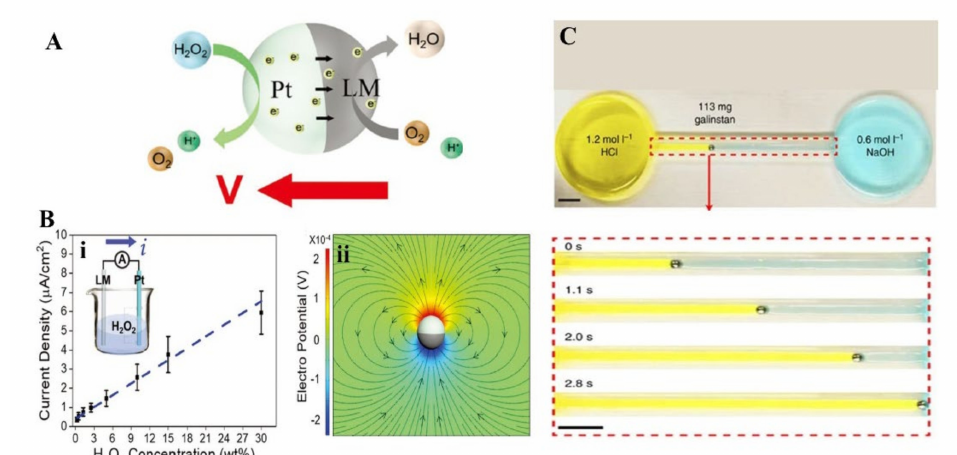
Figure 11. Chemically propelled MLMTs in H 2 O 2 or solution with PH difference. ( A ) Schematic illustration of the propulsion mechanism of Pt/Galinstan Janus motor [6]. ( B ) Electrochemical measurements ( i ) the current density of the LM–Pt system and simulated results ( ii ) of the electrical potential field around Pt/Galinstan Janus motors [6]. ( C ) LM droplet swims from 1.2 mol/L HCl to 0.6 mol/L NaOH reservoir